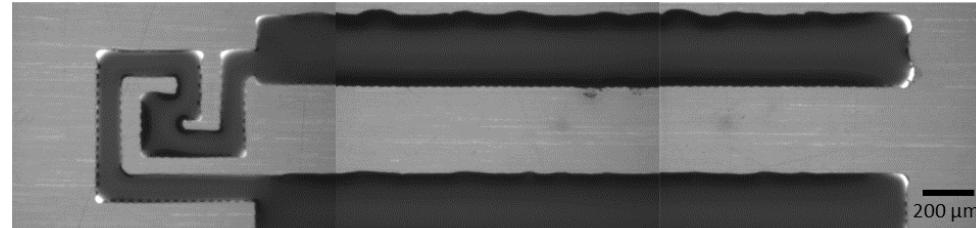
Figure 8. Single Pass Microheater with Three Passes of Interconnects